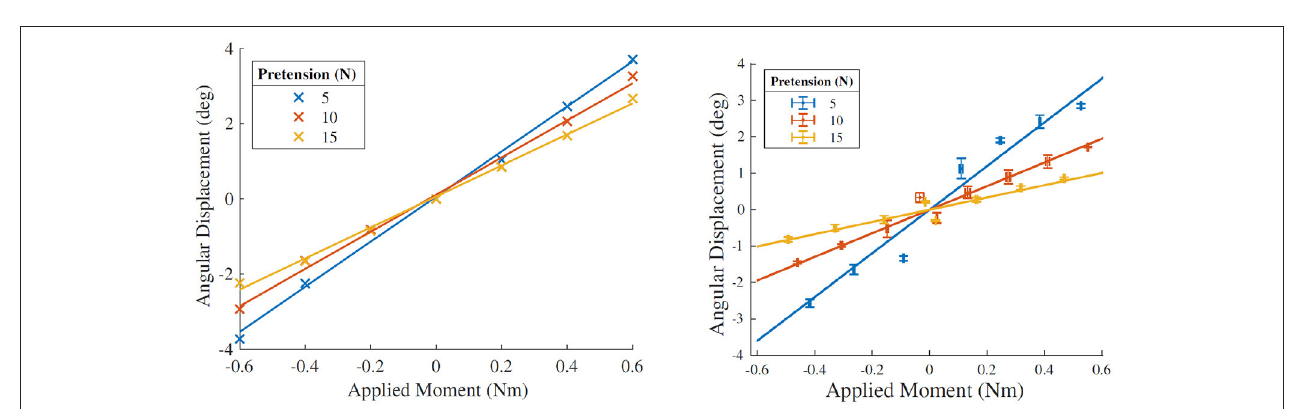
FIGURE 11 | (Left) Simulated angular displacement of the rigid surface of the dorsum attachment on application of moment loading under different conditions of strap stiffness. (Right) Angular displacement observed under identical conditions in the physical experiment. The HuRoSim model is able to predict the trends in effect of both the varied parameters of strap pretension and moment loading. However, under higher pretension, where the non-linear behavior of human soft tissue becomes more pronounced, there is expected divergence between the predicted and experimental